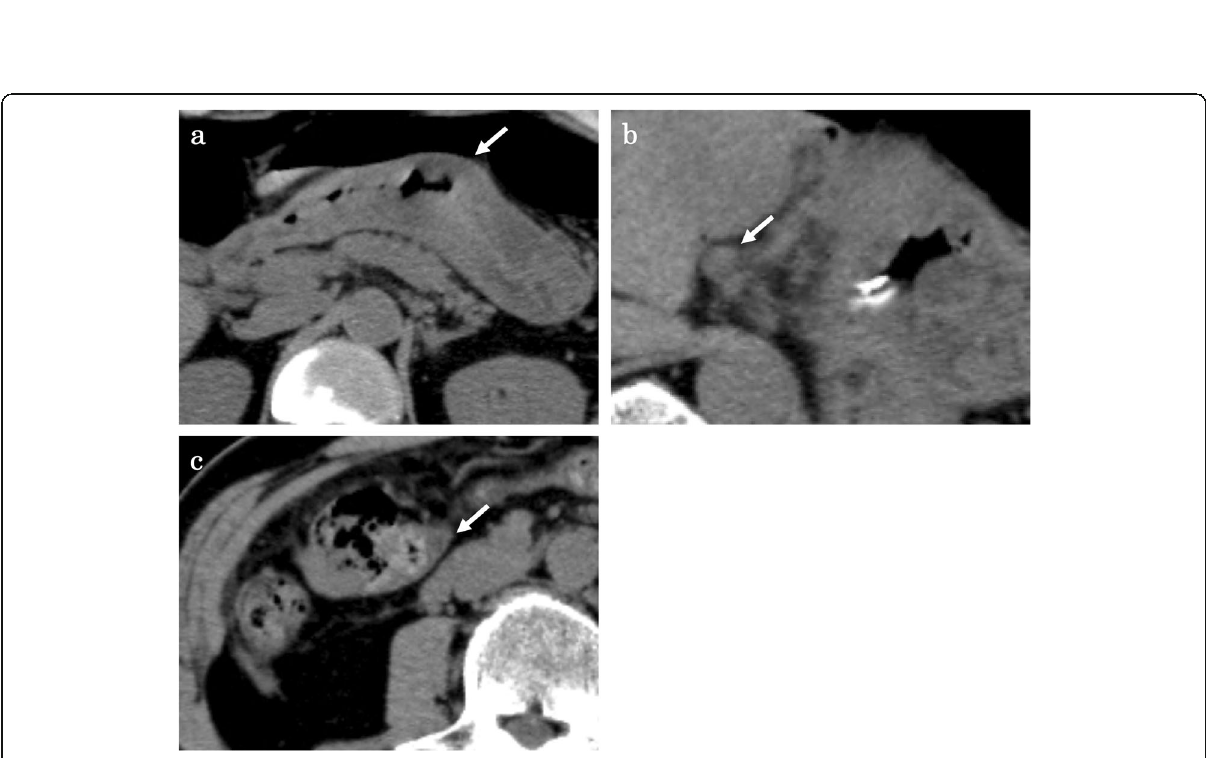
Fig. 2 CT findings before chemotherapy. a CT scan showed irregular wall thickness at the gastric body (white arrow). b CT scan showed lymph node enlargement at station 3 with a size of 7 × 11 mm (white arrow). c CT scan showed irregular wall thickness in the transverse colon (white